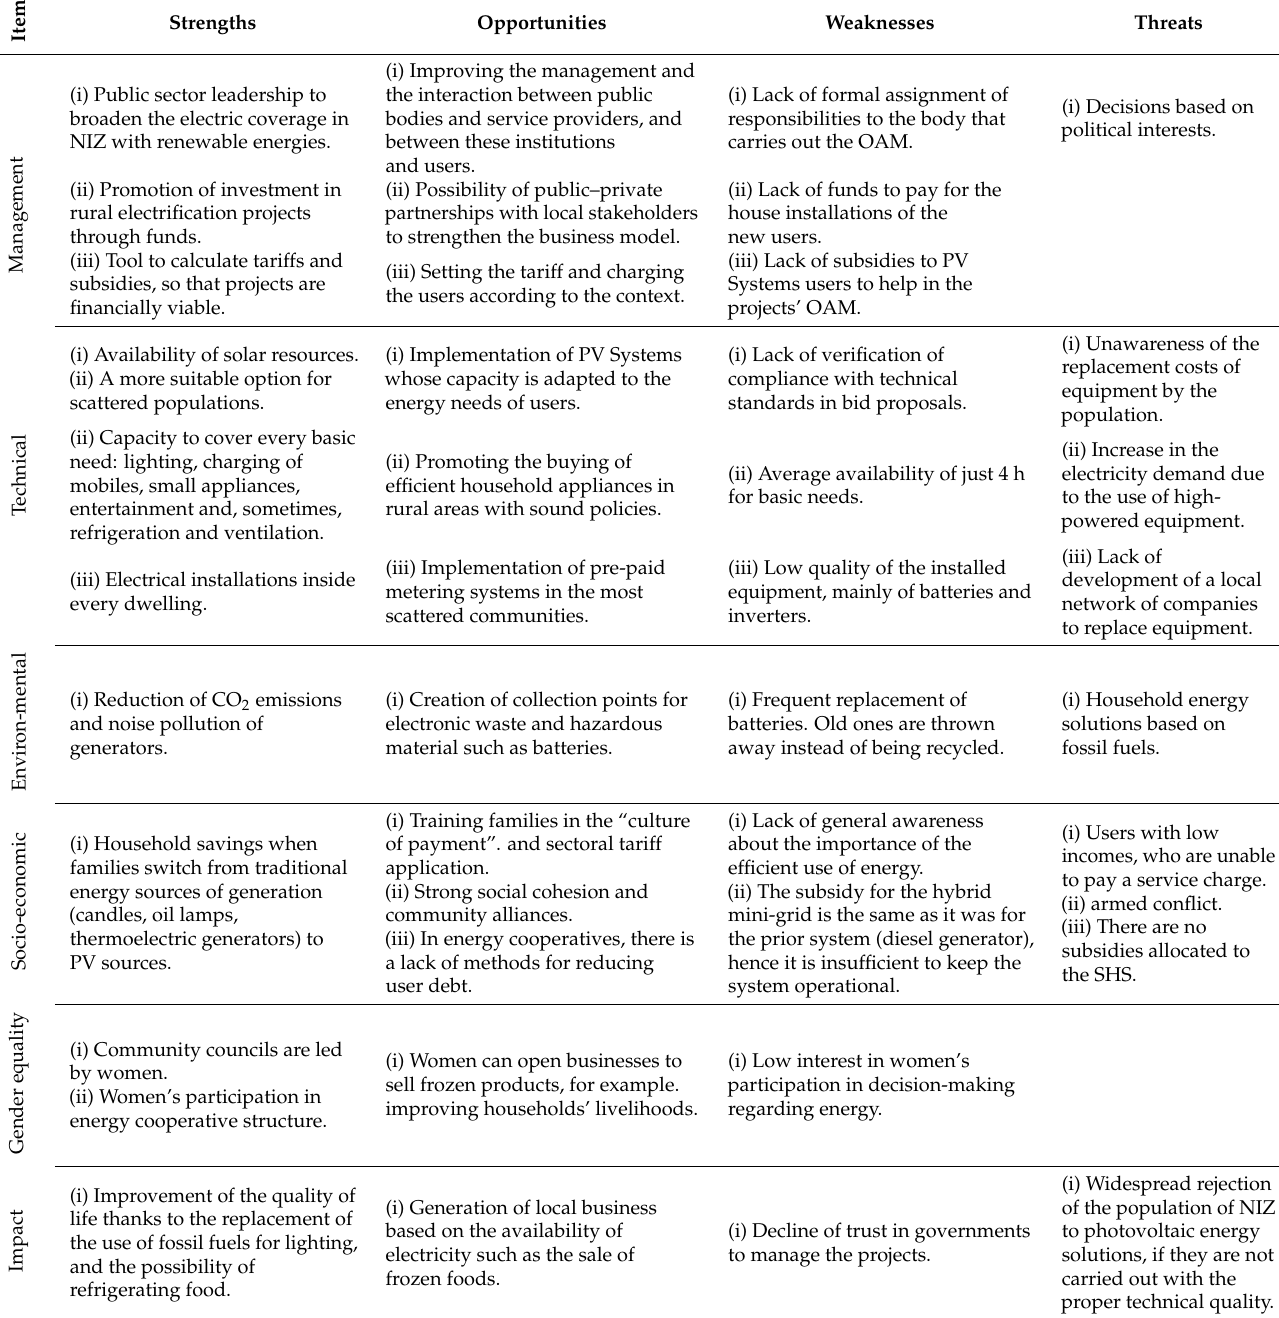
Table 2. SWOT analysis. Own